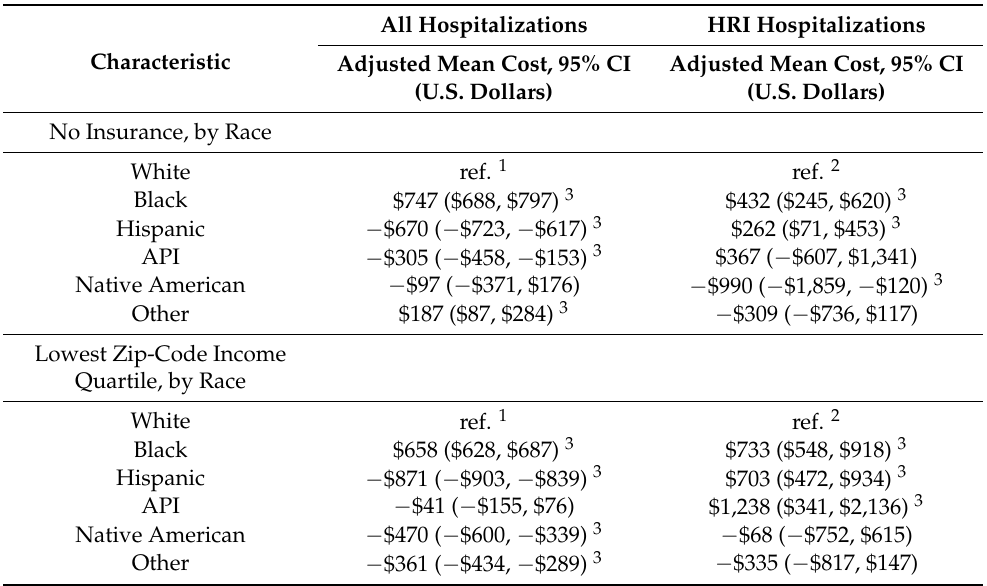
Table 4. Comparison of nationally adjusted mean costs per hospitalization for patients with no insurance and patients in the lowest zip-code income quartile, stratified by race 2001–2010